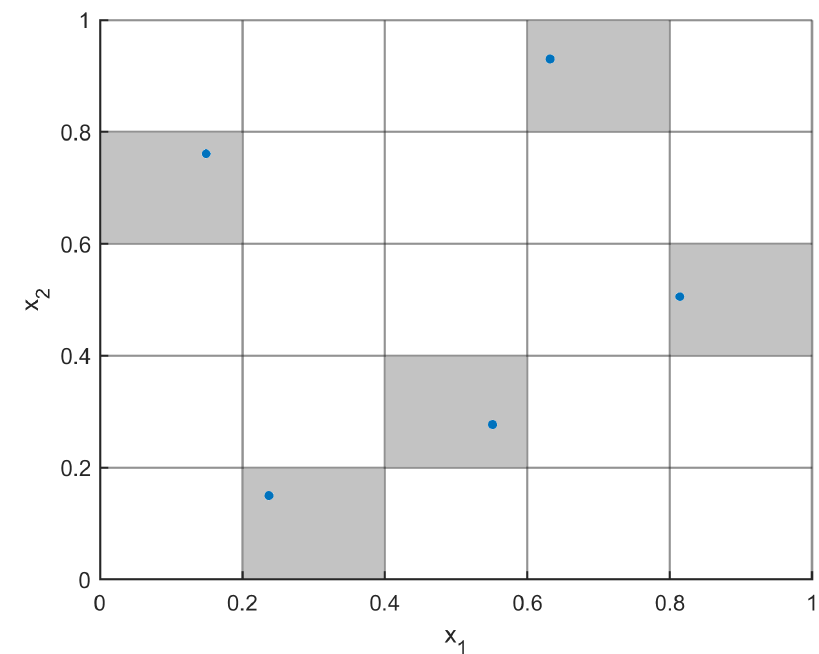
Figure 4. Latin-hypercube